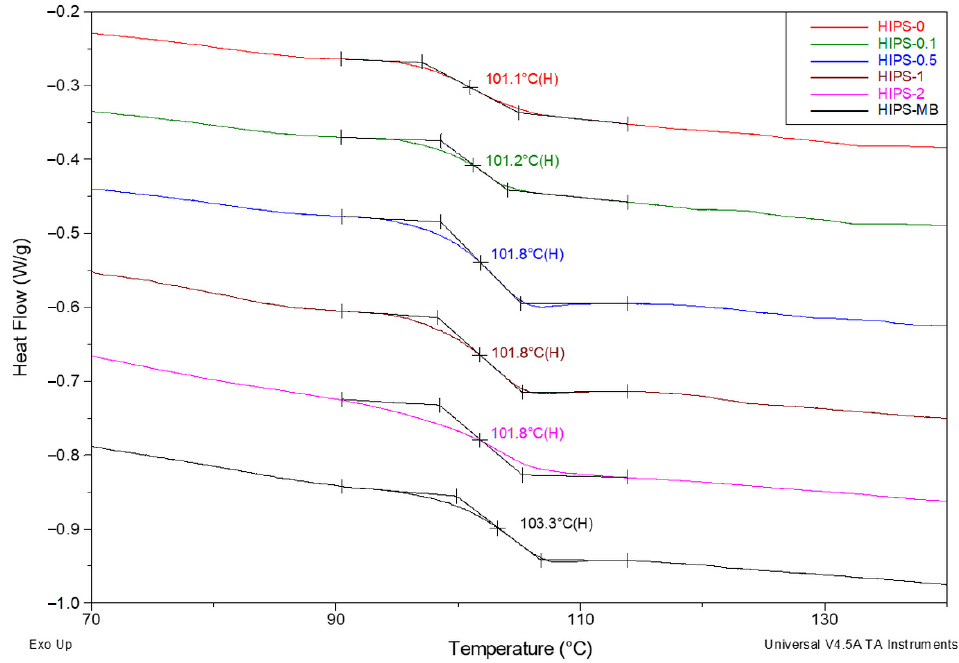
Figure 7. Summary of DSC curves for a series of HIPS filaments registered in the first heating cycle between 70 and 140 °C. Measurements carried out under nitrogen atmosphere, purge flow 40 mL/min. Heating rate 20 °C/min. Analysis of the area of thermal glass